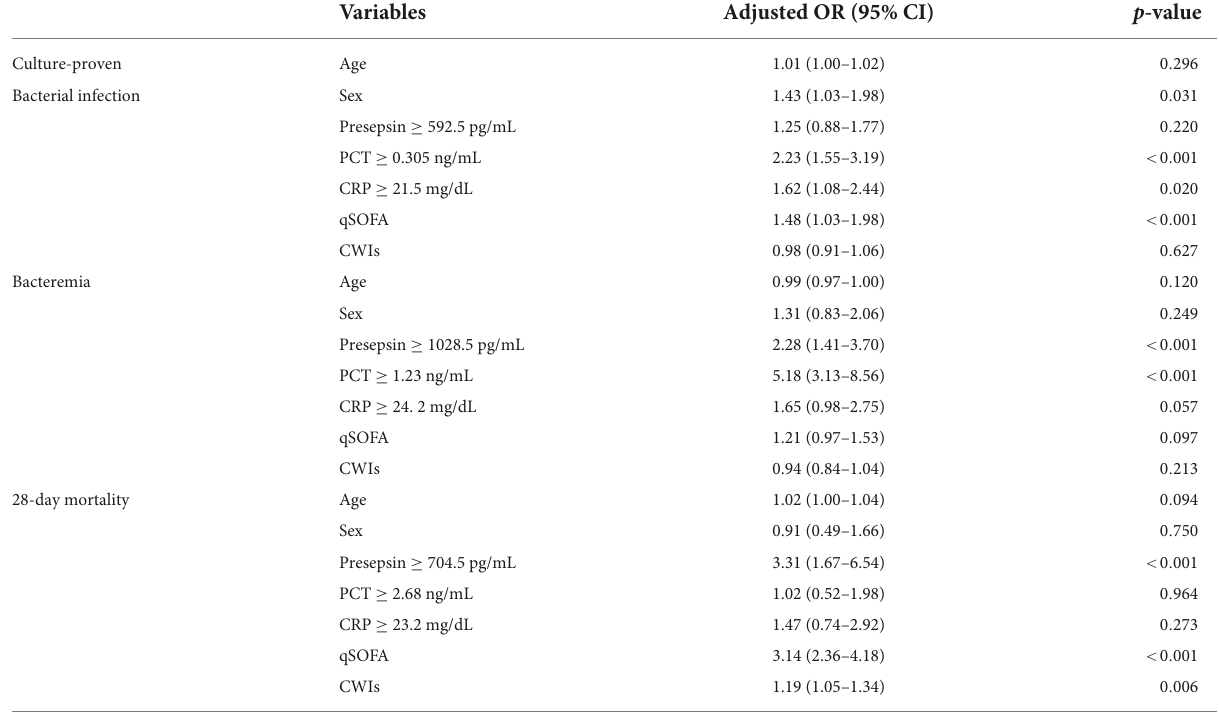
TABLE 2 Independent factors for predicting culture-proven bacterial infection, bacteremia, and 28-day